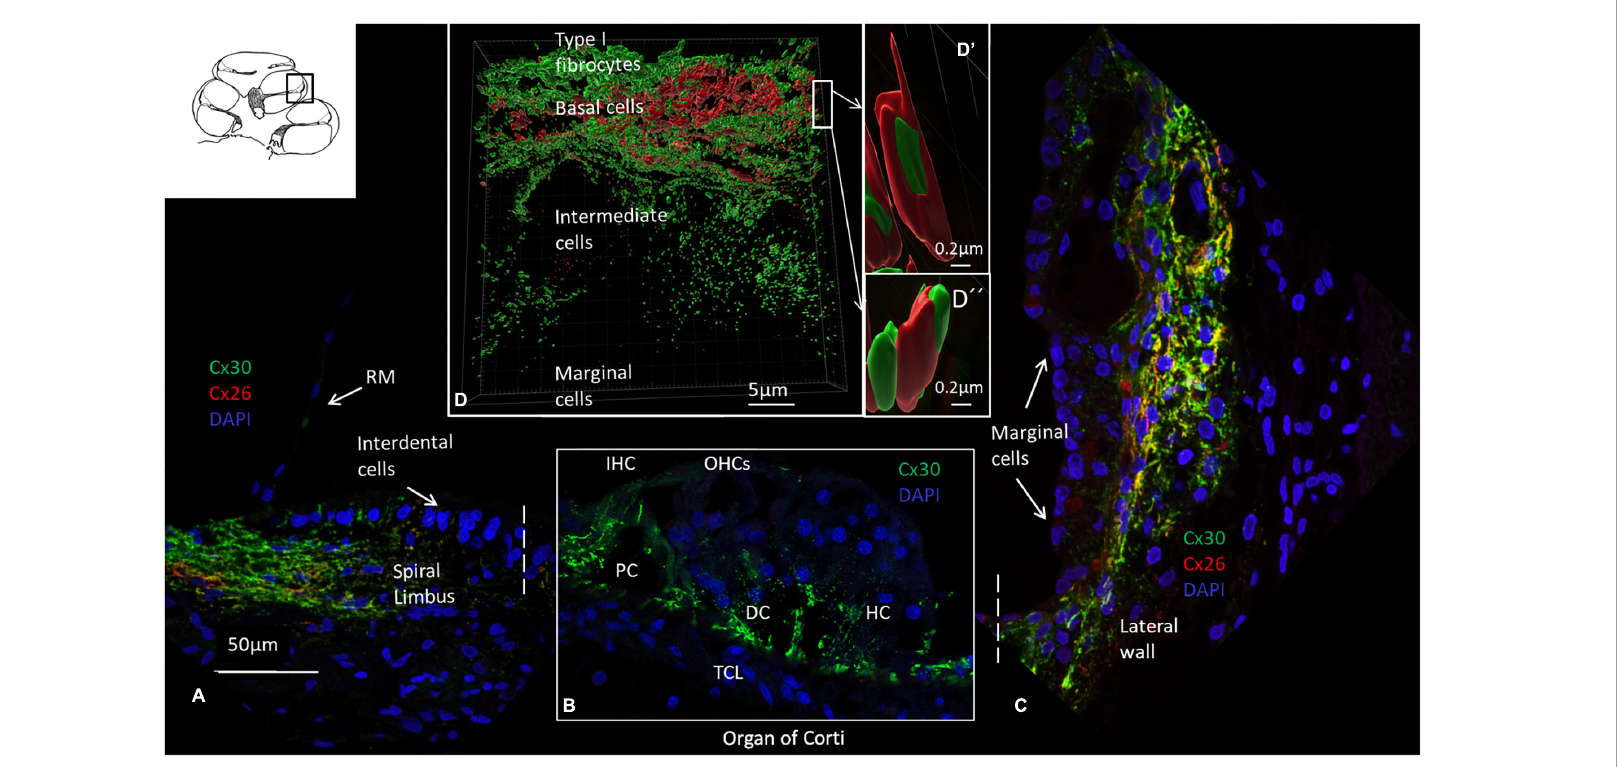
FIGURE2 Confocal microscopy, SR-SIM, and Cx26 and Cx30 antibody labeling of the organ of Corti and lateral wall. (A) Cx26 and Cx30 are expressed in the spiral limbus fibrocytes. There is no expression in Reissner’s membrane (RM). (B) The OC expresses both Cx26 and Cx30, but in Figure B, only Cx30 is shown. IHC: inner hair cell. OHCs: outer hair cells. PC: pillar cell. HC, Hensen cell; DC, Deiters cell. TCL: tympanic covering layer. (C) Cx26 and Cx30 are both jointly and separately expressed in the lateral wall. Cx30 dominates except at the basal cell area of the stria vascularis. There is no expression in the marginal cells or in cells laterally margining the bone (type III fibrocytes). (D) SR-SIM using spot detection mode (Imaris 9.5.1) demonstrates separate and closely associated protein labeling with geometric arrangements in the lateral cochlear wall (D’ and D"). Cx30, but not Cx26, is expressed in the intermediate cells. The cochlear turn is not